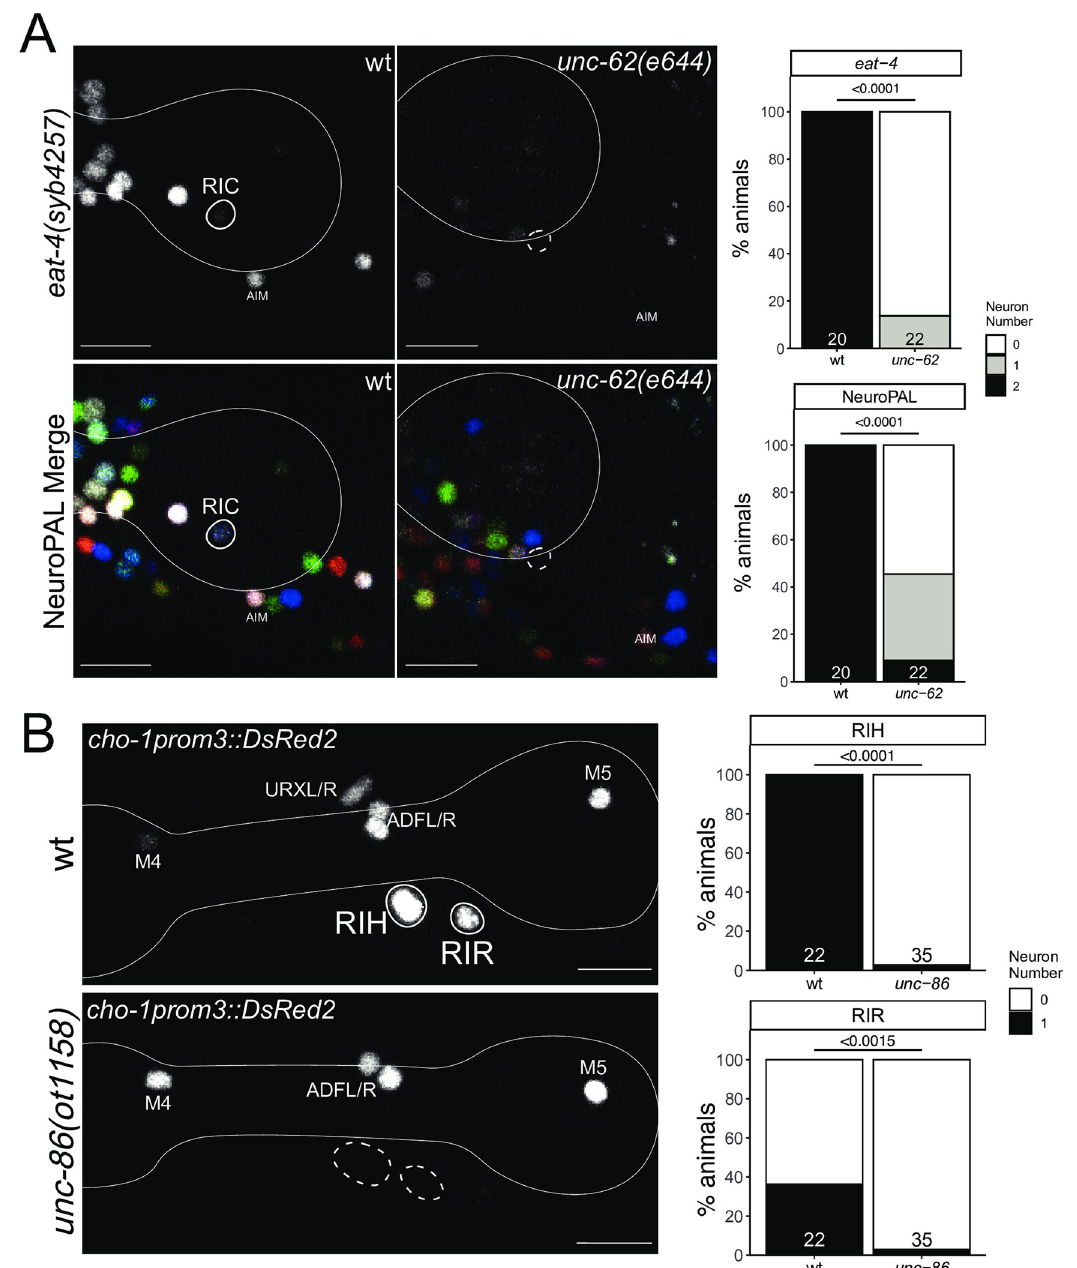
Fig 9. Ring interneuron (RIC, RIH, RIR) differentiation defects in homeobox gene mutants. Fig 9A: unc-62(e644) mutant animals show a loss of RIC marker expression, including an eat-4 CRISPR reporter ( syb4257) and NeuroPAL ( otIs669 ). Representative images of wild type and mutant worms are shown with 10 μ m scale bars. Graphs compare expression in wild type and mutant worms with the number of animals examined listed at the bottom of the bar. P-values were calculated by Fisher’s exact test. Fig 9B: unc-86(ot1158) mutant animals show loss of RIH and RIR marker expression of an extrachromosomal cho-1prom3 reporter ( otEx4530 ) [105]. Representative images of wild type and mutant worms are shown with 10 μ m scale bars. Graphs compare expression in wild type and mutant worms with the number of animals examined listed at the bottom of the bar. In all panels, neurons of interest are outlined in solid white when expressing wildtype reporter colors, and dashed white when one or all colors are lost. P-values were calculated by Fisher’s exact